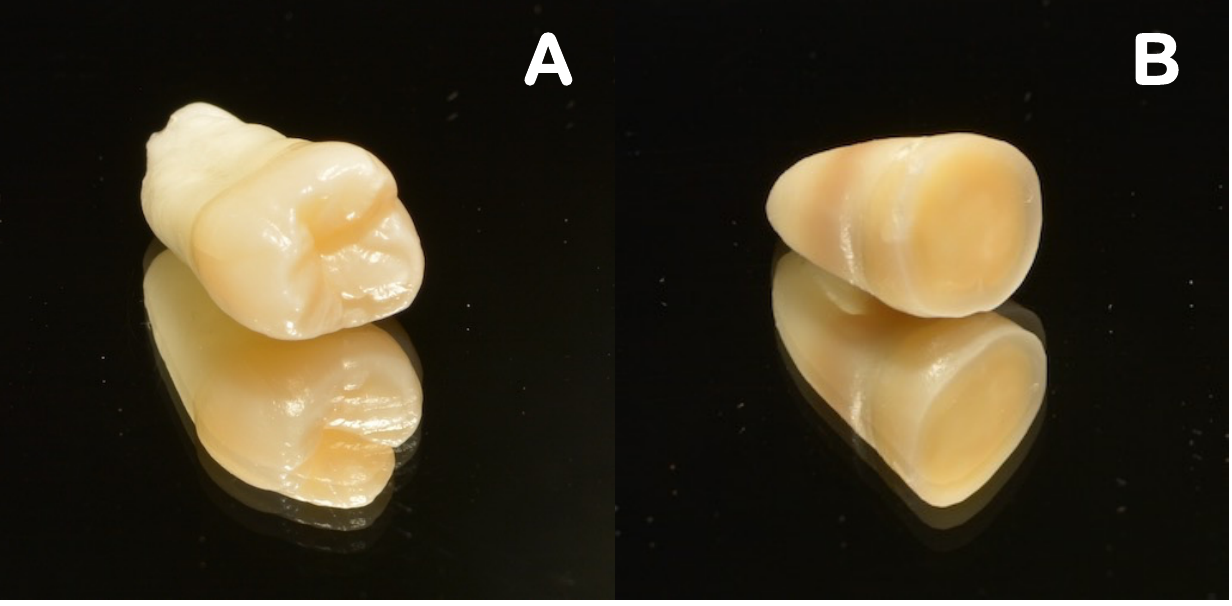
Figure 2. Example of a tooth selected for the study: ( A ) permanent and non-carious human molar; ( B ) longitudinally sectioned tooth.